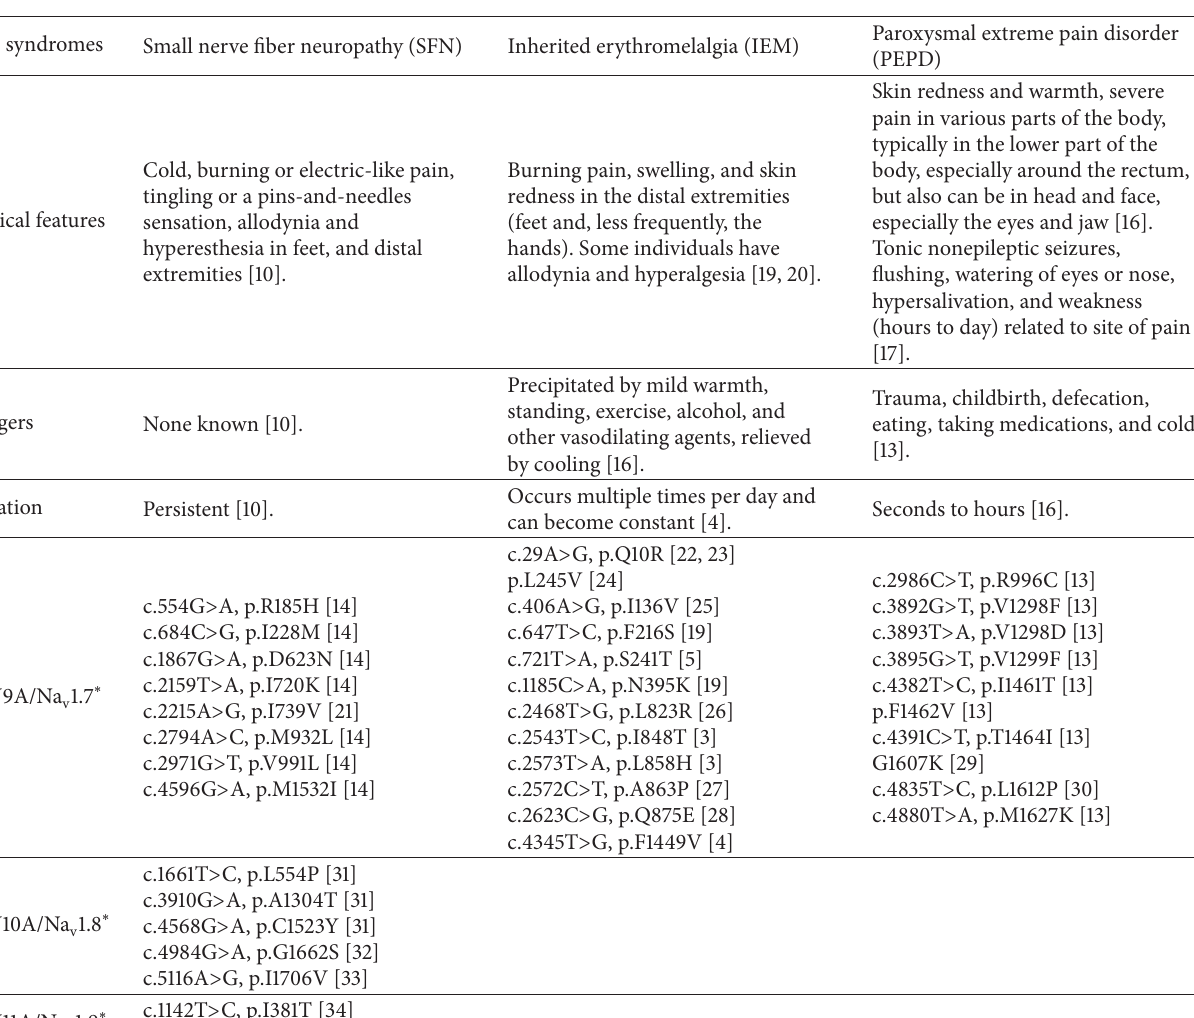
Table 1: Clinical features, triggers, and mutations of sodium channel pain syndromes. Differences between small nerve fiber neuropathy, inherited erythromelalgia, and paroxysmal extreme pain disorder. ∗ The mutations listed are meant to demonstrate phenotypic variability in single mutations; this is not an exhaustive list of